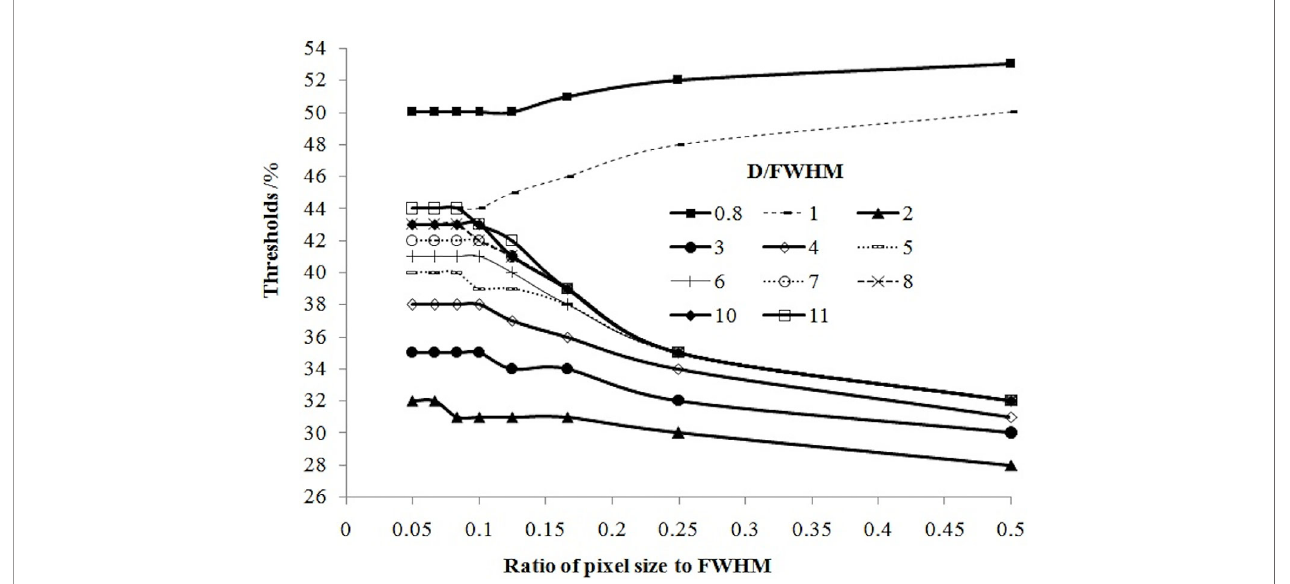
FIGURE 5 | Variation in the threshold as a function of the pixel size normalized by